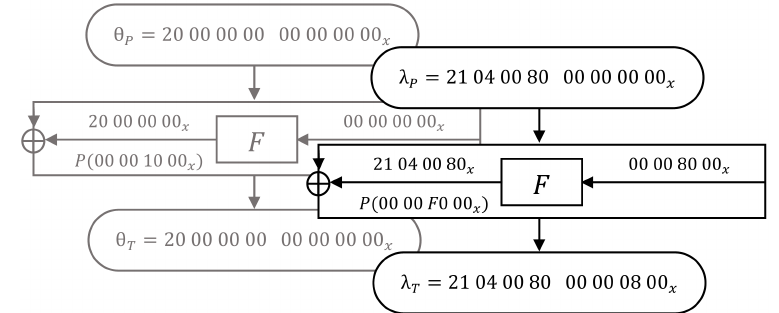
Figure 6: λ 1 Conditioned on the LSB of the Four Output Bits of S 5 ( λ 1 | θ 1 )